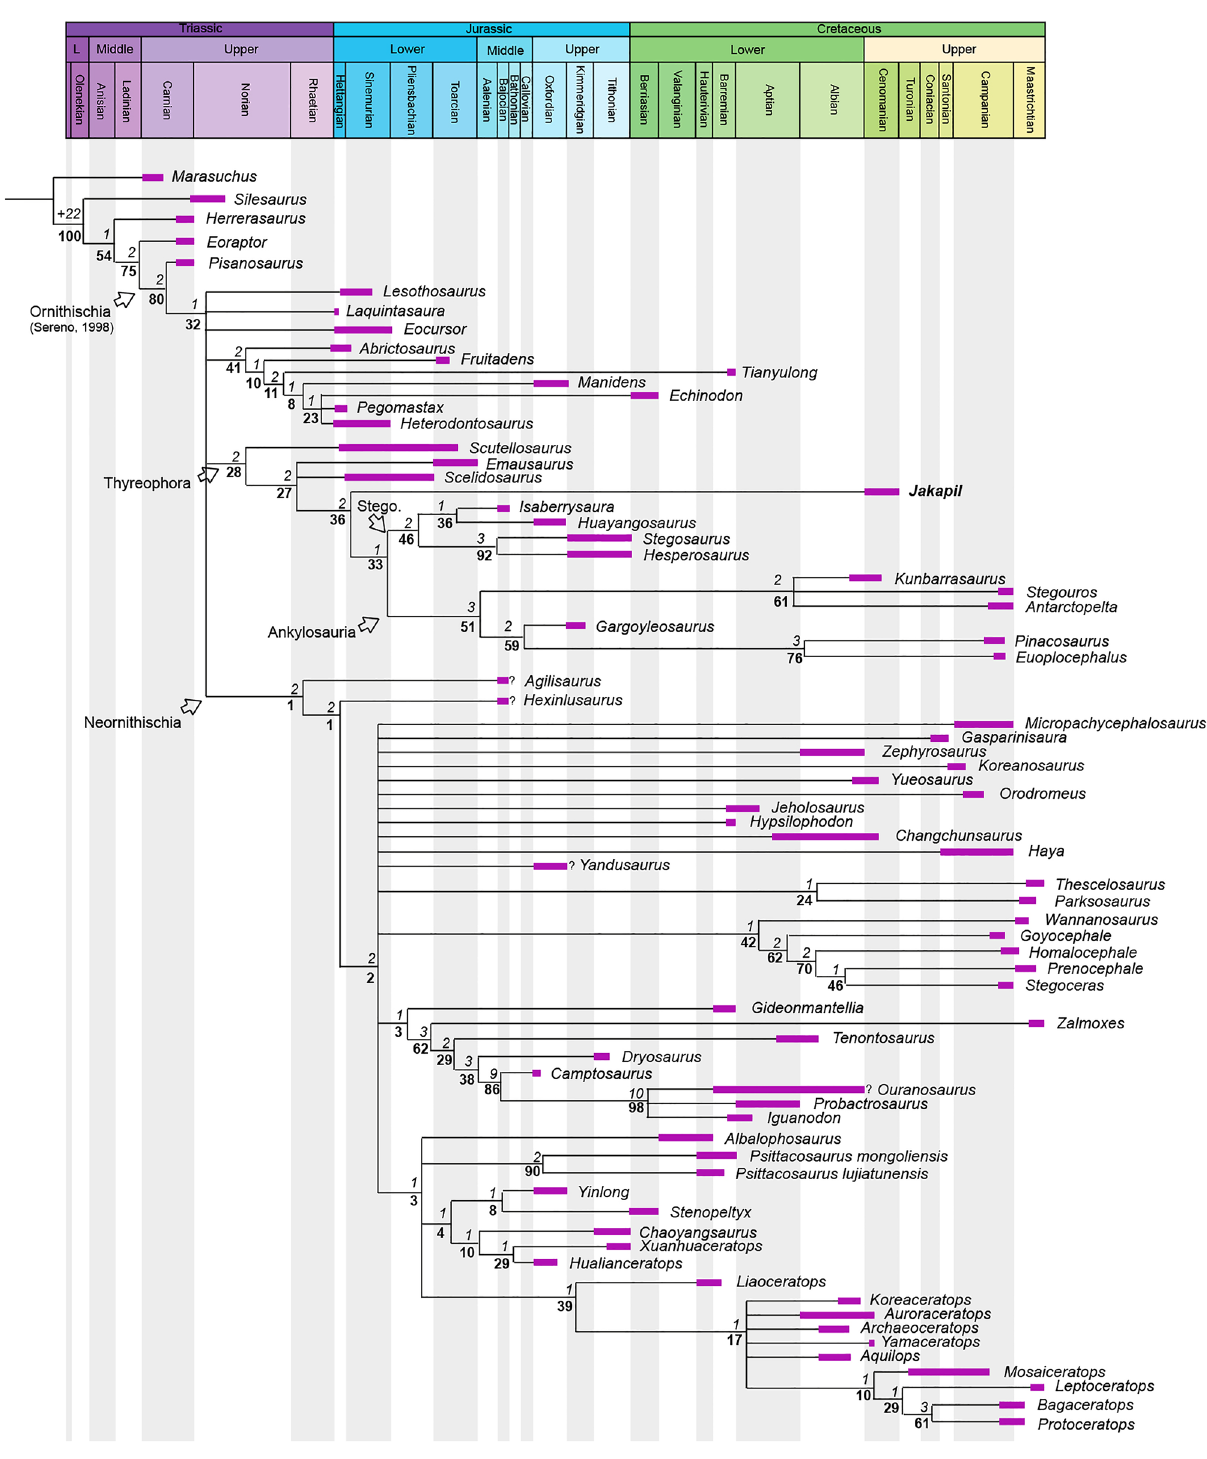
Figure 5. Time-calibrated strict consensus of 26,784 most parsimonious trees (L = 1267) with the Soto-Acuña et al. 5 matrix. CI 0.359, RI: 0.708. Branch supports are figured (Bremer/bootstrap). Record ages references are listed in the Supplementary Information (Suppl. Fig.